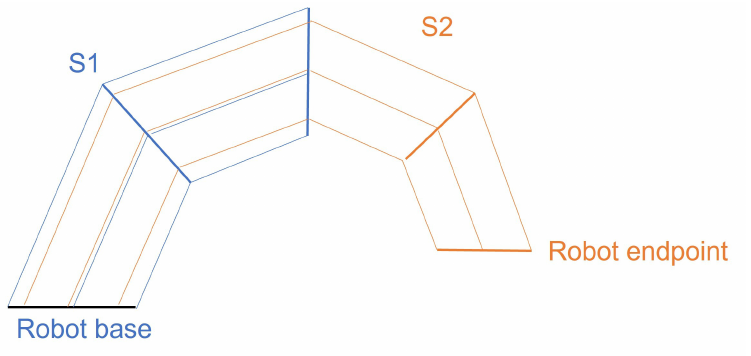
Figure 13. Cables’ length for multisection